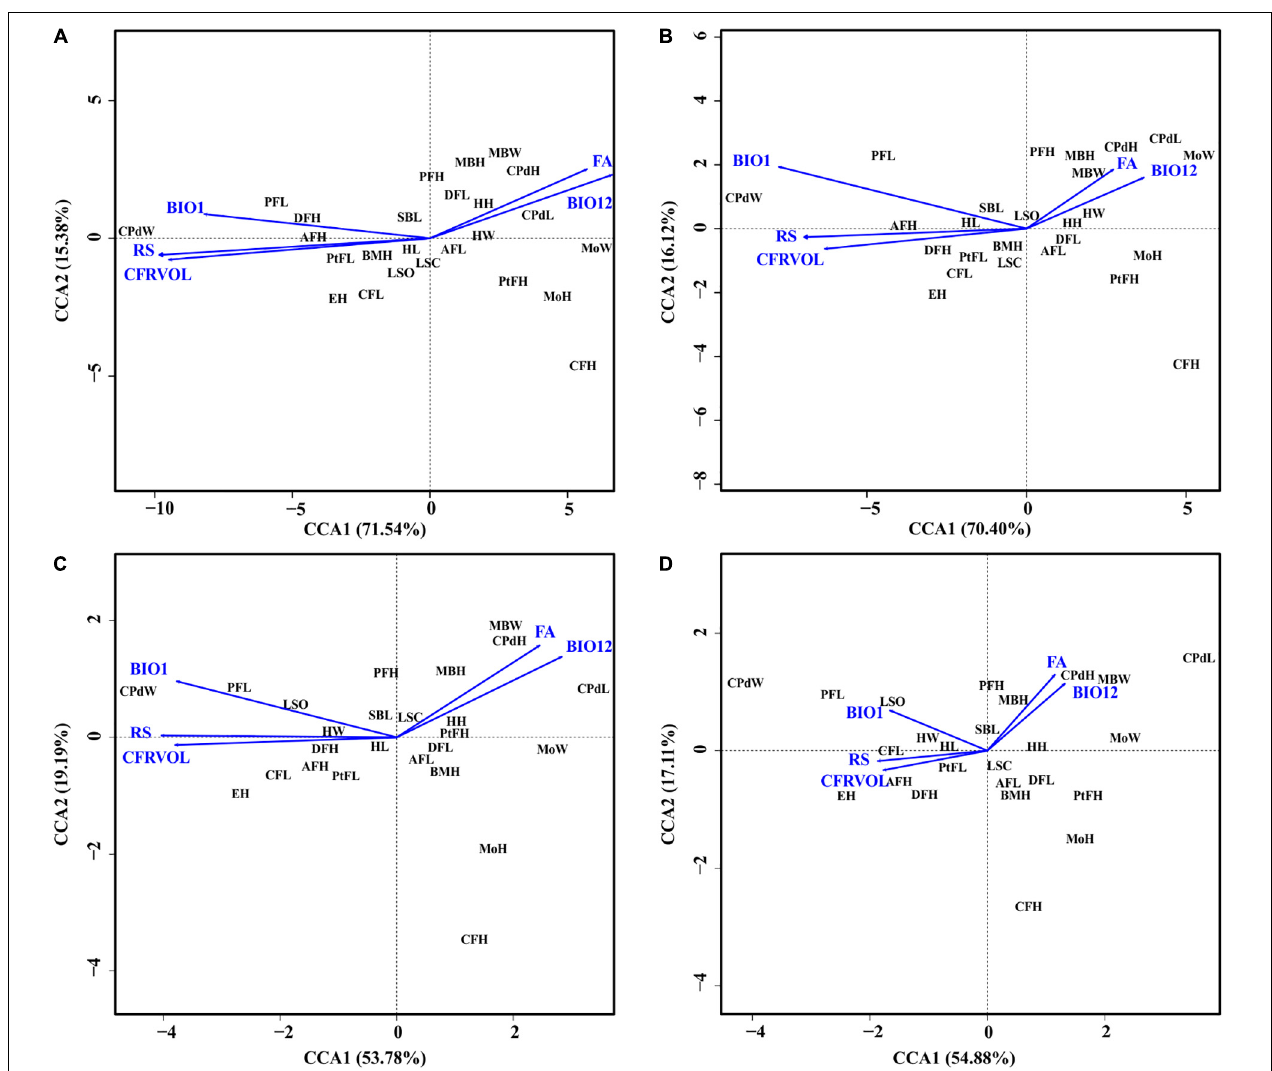
FIGURE 7 | The canonical correspondence analysis biplots showing the relationship between morphological traits and environmental variables (A) without considering genetics, (B) taking genetic variation into account, (C) taking dispersal (via gene flow) into account, (D) considering both genetic variation and dispersal. Five environmental variables representing river topology, soil classification and hydroclimate were used, namely: annual mean temperature – BIO1, annual precipitation – BIO12, average river slope – RS, flow accumulation – FA, and coarse fragments volumetric across sub-catchment – CFRVOL. Morphological trait abbreviations correspond to those used in Table 1